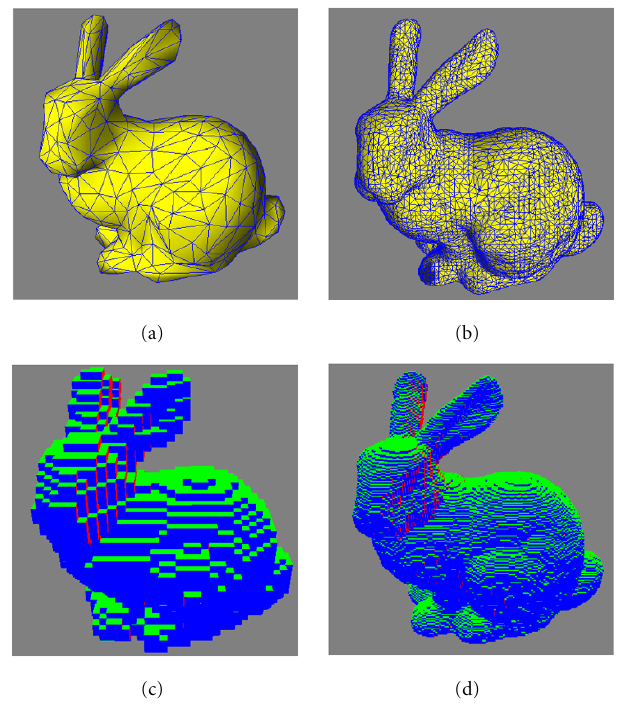
Figure 8: Di ff erent representations of the Bunny model. (a) Simplified mesh at low resolution (1 . 2% of the original). (b) Simplified mesh at middle resolution (15 . 1% of the original). (c) Rough voxel. (d) Fine